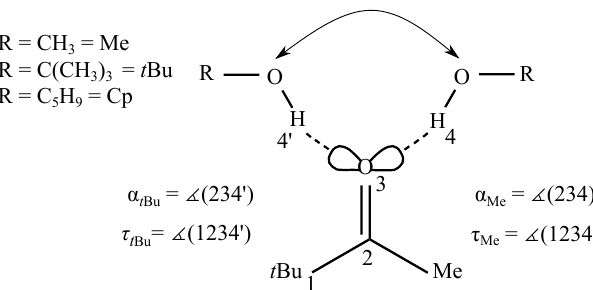
Figure 1. Schematic representation of the two possible docking sides 4 and 4 (cid:48) in a pinacolone molecule ( t Bu and Me) with different alcohols (R-OH, with the abbreviations Me for methyl, t Bu for tert -butyl and Cp for cyclopentyl as